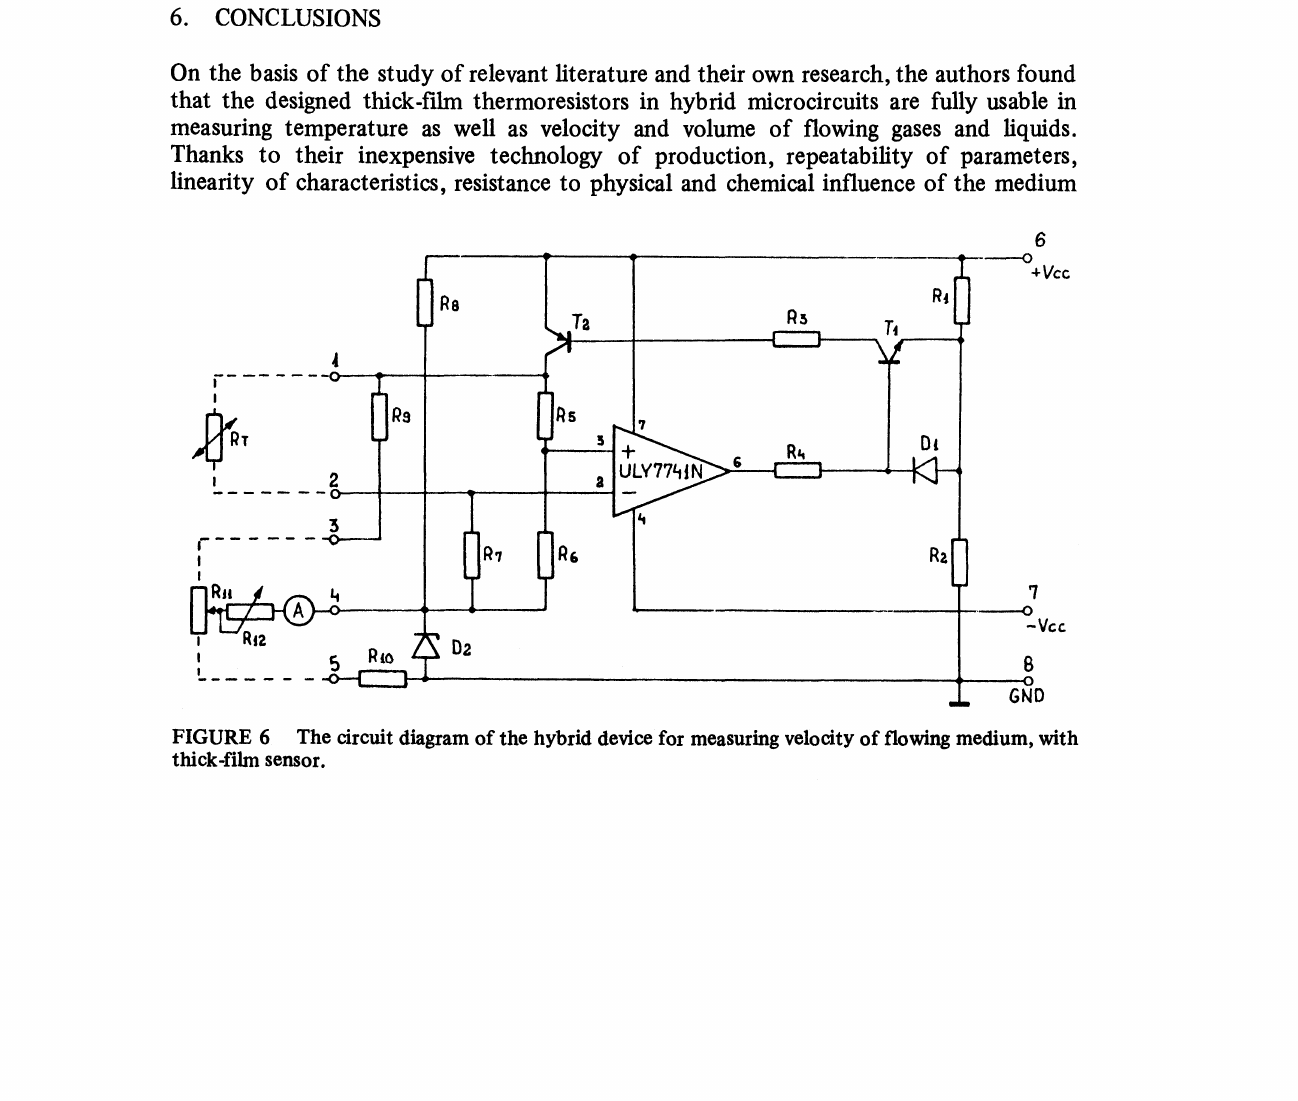
The circuit diagram of the hybrid device for measuring velocity of flowing medium, with thick -film